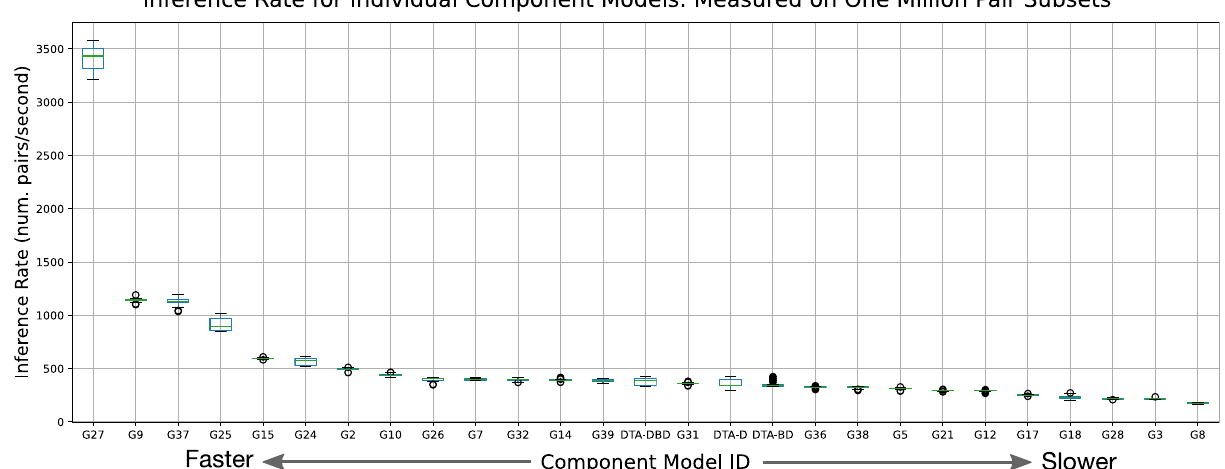
Figure 4. Inference rates of each component model measured over random subsets of 1 million